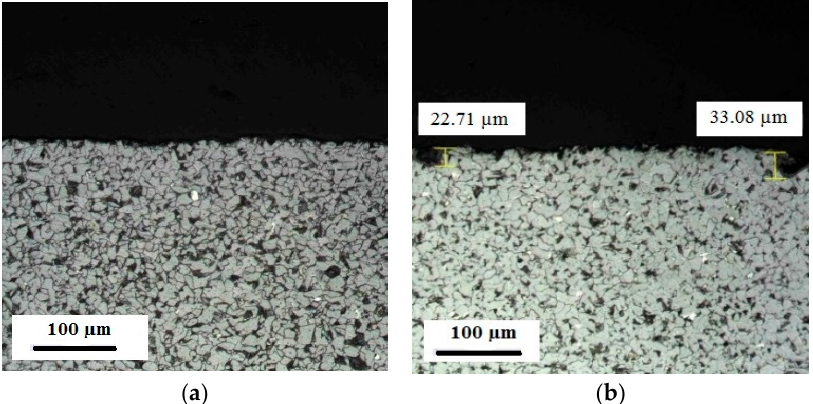
Figure A3. Microscopic images of the cross-section of CS-Bare ( a ) before and ( b ) after the low-temperature corrosive attack after 168 h.